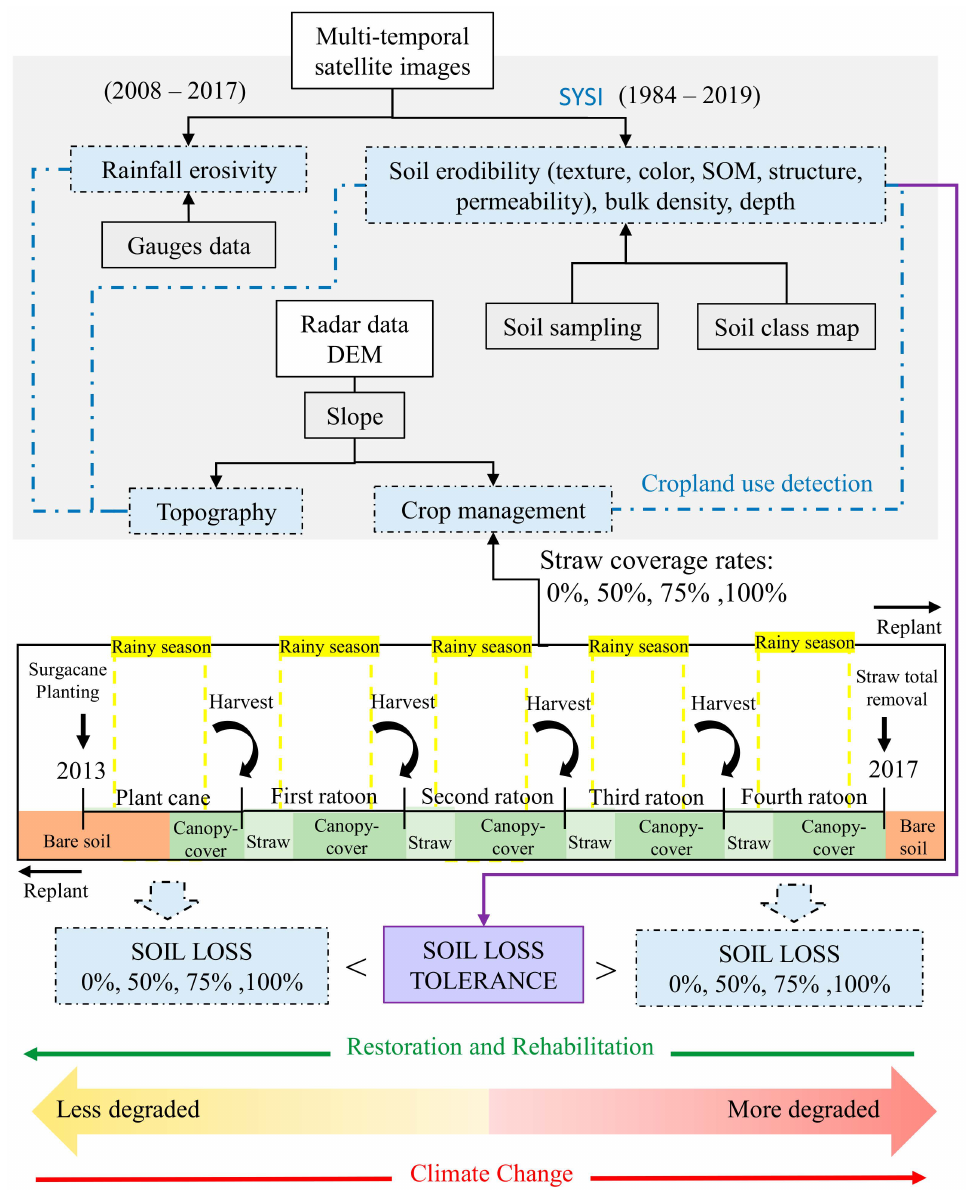
Figure 2. Flowchart of the methodology to obtain soil loss. The multi-temporal satellite image and field observations data used to estimate and validate rainfall erosivity and soil erodibility, and a digital elevation model used to derive the slope. The Synthetic Soil Image (SYSI) technique based on remote sensing and soil spectroscopy-derived soil attributes maps to calculate soil erodibility, soil loss tolerance and detect the cropland use spatial patterns. The environmental variables (rainfall, erodibility and topography) associated with the cropland patterns and the cropland management dataset (five years of the sugarcane cycle) under different amounts of straw (0%, 50%, 75%, and 100%) estimate soil loss. Soil loss higher than the tolerance indicates high land degradation that contributes to increasing climate change crises, while lower indicates the restoration and rehabilitation of the